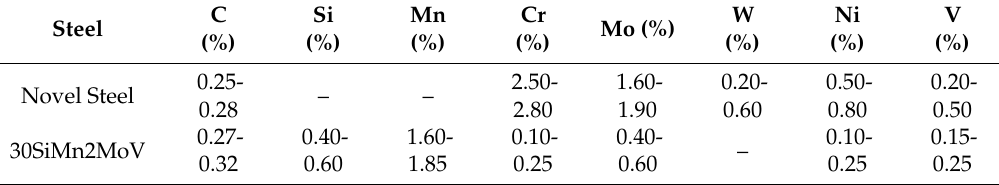
Figure 1. Tempering SEM microstructure of the experiment material: ( a ) novel steel and ( b ) 30SiMn2MoV.